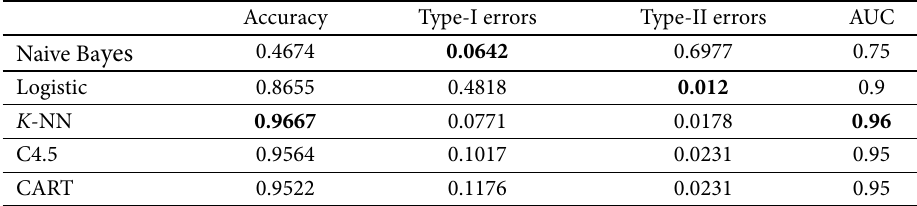
Table 2. Classification results on the PCA test dataset